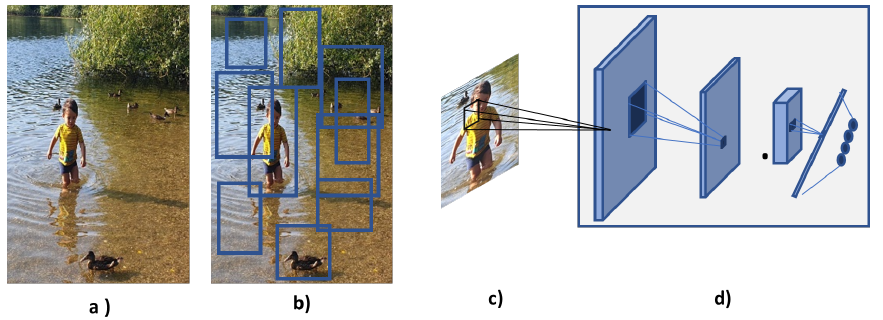
Figure 7. R-CNN architecture: ( a ) Input Image. ( b ) Region proposals are acquired using selective searching technique. ( c ) The regions of interest are warped or cropped and used as the input to the CNN. ( d ) CNN extract features and classify the proposed regions of interest